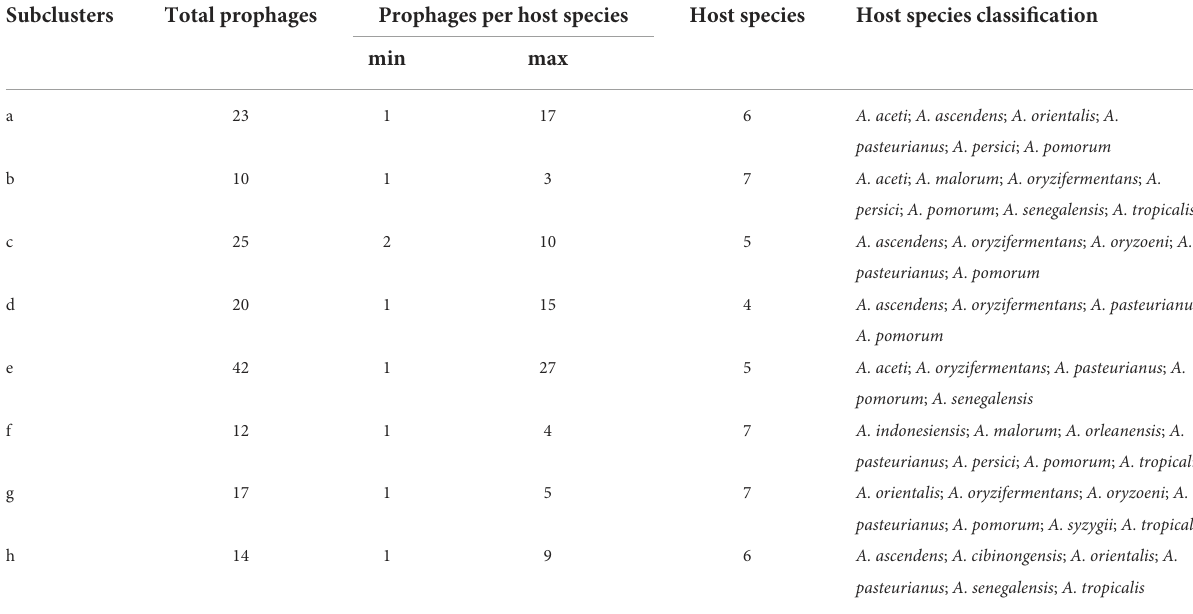
TABLE 1 Distribution of prophages grouped in the eight large